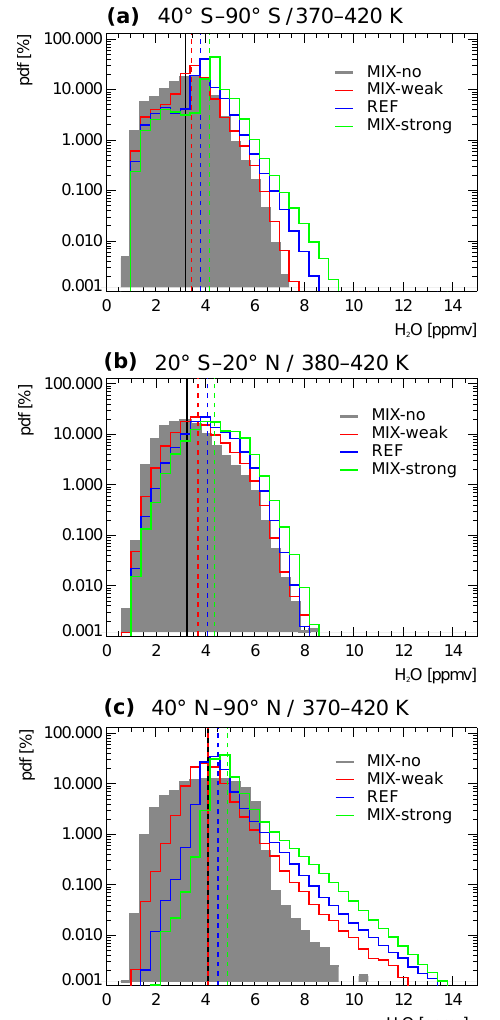
Figure 11. Probability density function (PDF) for water vapour mixing ratios in the SH extratropics for 40–90 ◦ S between 370 and 420K (a) , in the tropics for 20 ◦ S–20 ◦ N between 380 and 420K (b) , and in the NH extratropics for 40–90 ◦ N between 370 and 420K (c) . Shown data are from 2011 CLaMS sensitivity simulations with different strength of small-scale mixing for the case without mixing (MIX-no, grey shading background), weak mixing (MIX-weak, red solid line), reference simulation (REF, blue solid line) and strong mixing (MIX-strong, green solid line). Dashed coloured lines rep- resent the mean H 2 O values for the different simulations respec- tively, whereas the black solid line shows the mean value for the non-mixing case.